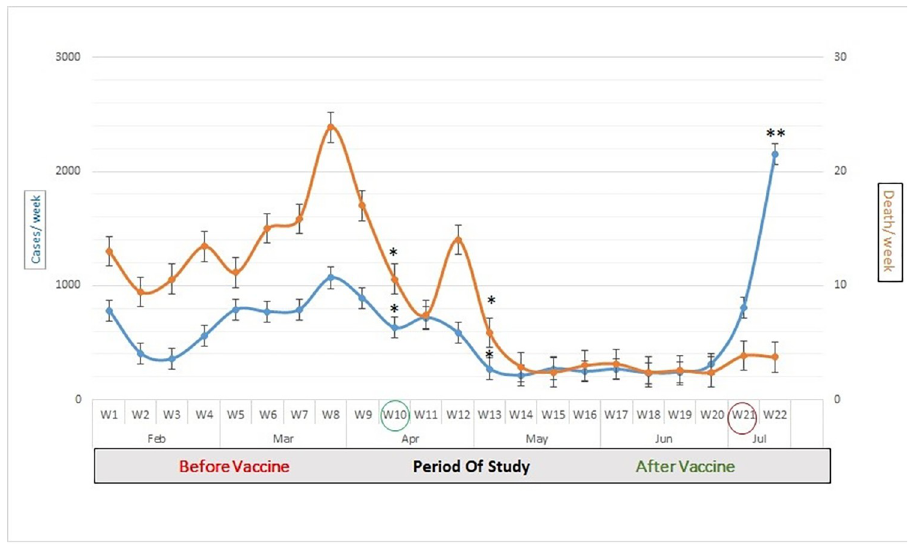
Fig 1. Mean of patients with confirmed SARS-COV-2 infection from February to 15 July in Libya, ( � ): High significant different (a p-value < 0.05 was considered significant); ( �� ): Very high significant different (a p-value < 0.05 was considered significant). Green ring: start to vaccines program; Red ring: first cases with Delta